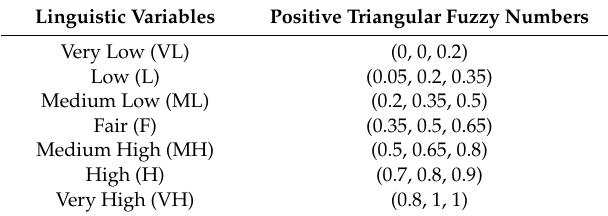
Table 2. Membership function of fuzzy numbers for information system